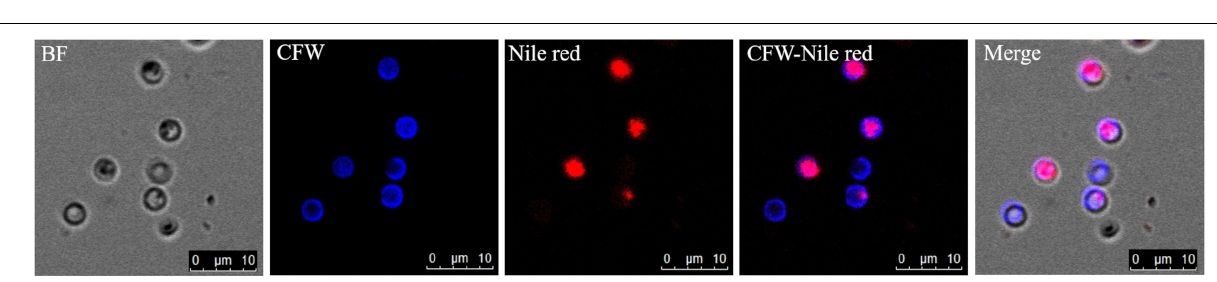
FIGURE 11 | Resting spores of Plasmodiophora brassicae stained with the dual staining of CFW-Nile red with confocal microscopy. BF: resting spores under bright field; CFW: cell wall of resting spores stained with calcofluor white; Nile red: lipid droplets stained with Nile red; CFW-Nile red: merge image of dual staining; Merge: merge image of dual staining and bright field (Pink color indicates non-germinated spores, blue color indicates germinated spores).